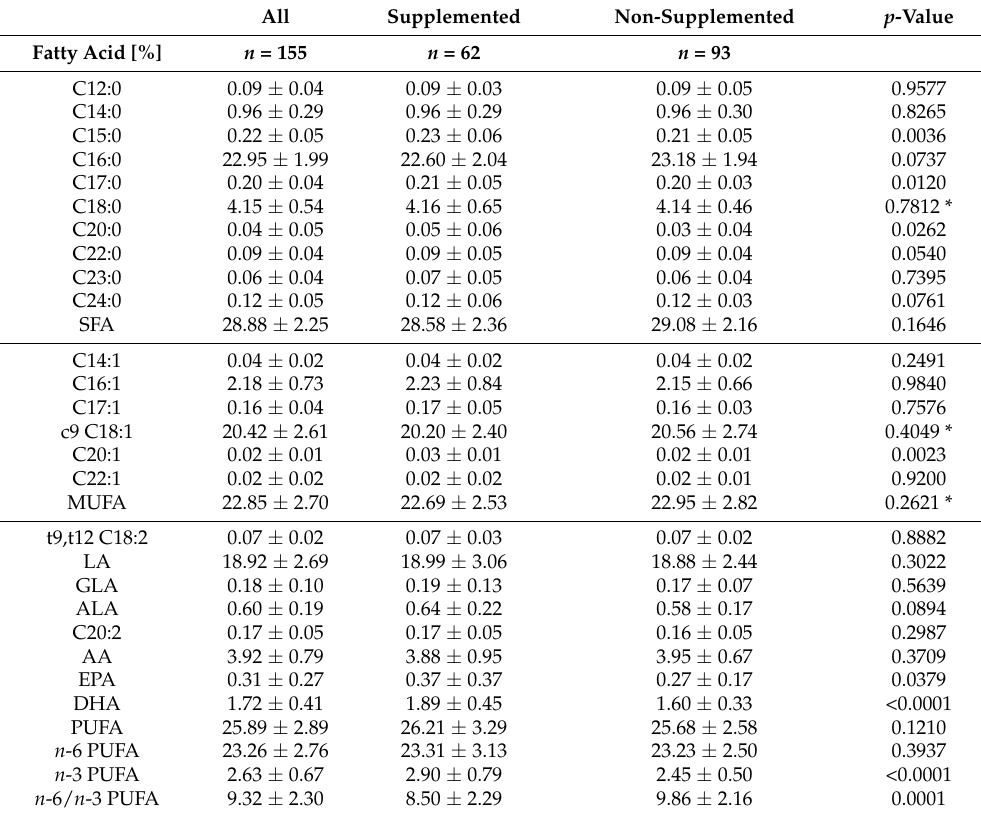
Table 2. Fatty acids profile in maternal serum. All